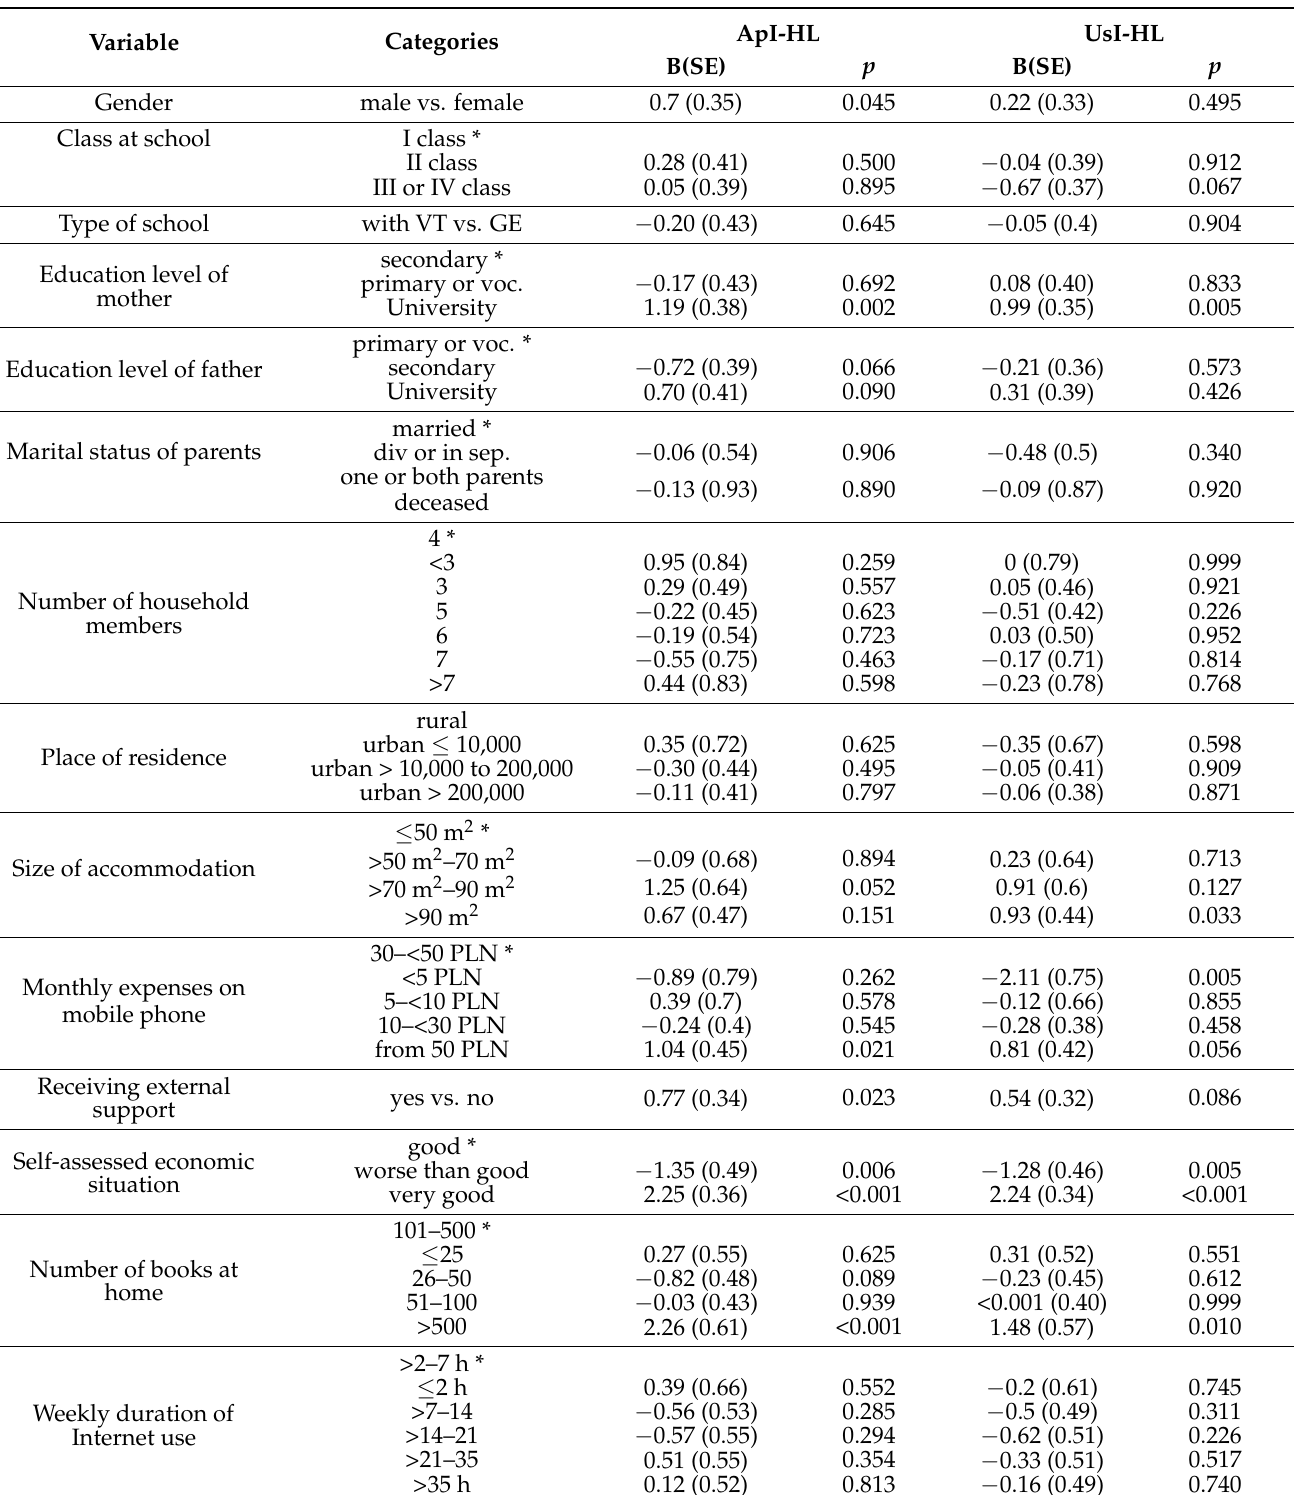
Table 5. Univariate linear regression models for ApI-HL and